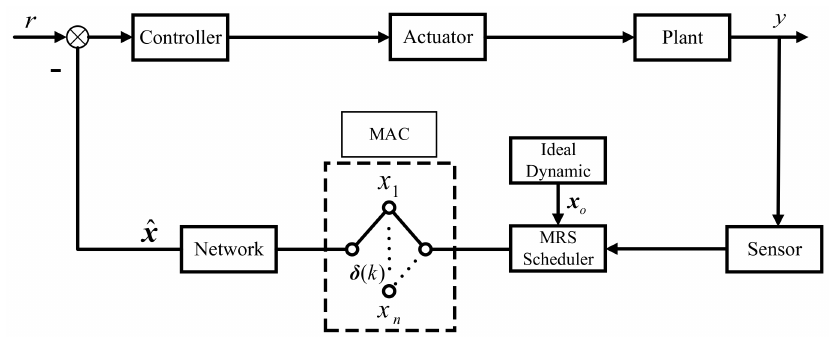
Figure 4. NCS with the GMRS